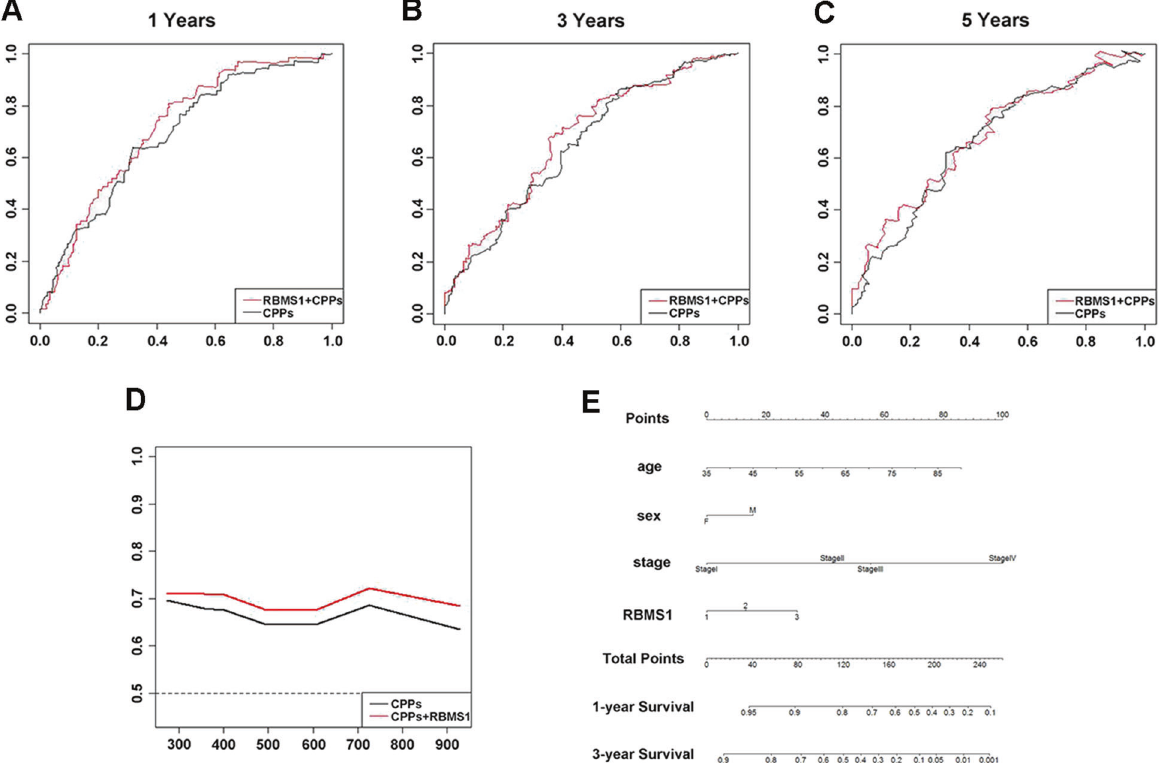
Fig. 3 New model combining CPPs with RBMS1 predicts poor clinical outcomes in GC better than CPPs alone. A – C Calibration plots of the nomogram-predicted and observed 1-, 3- and 5-year survival rates. The nomogram-predicted probability of survival was plotted on the x -axis, and actual survival was plotted on the y -axis. Dashes: ideal model; vertical bars, 95% con fi dence interval. D Time-dependent receiver operating characteristic (ROC) analysis showed that the combination of RBMS1 with CPPs increased the prediction accuracy of traditional CPPs for overall survival. E Nomogram for predicting 1-, 3-, and 5-year survival in GC patients. CPPs, clinicopathological